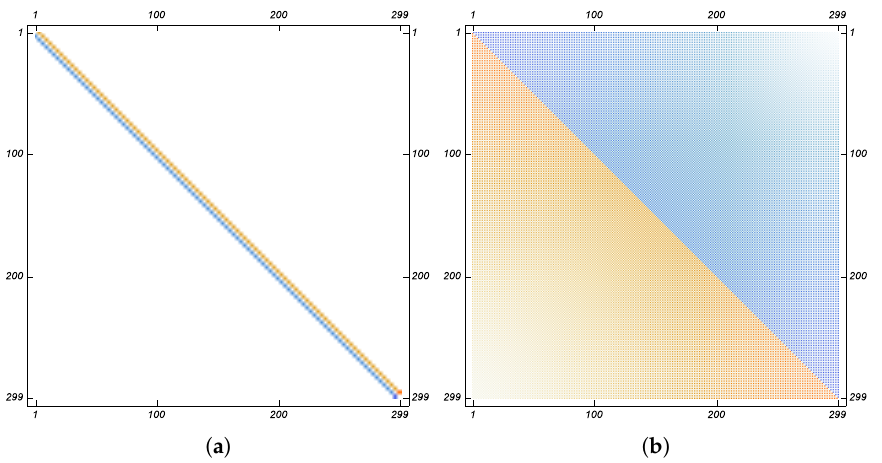
Figure 6. Representation of the ( a ) matrix and ( b ) Drazin inverse matrix for Example (5) with n = 299,